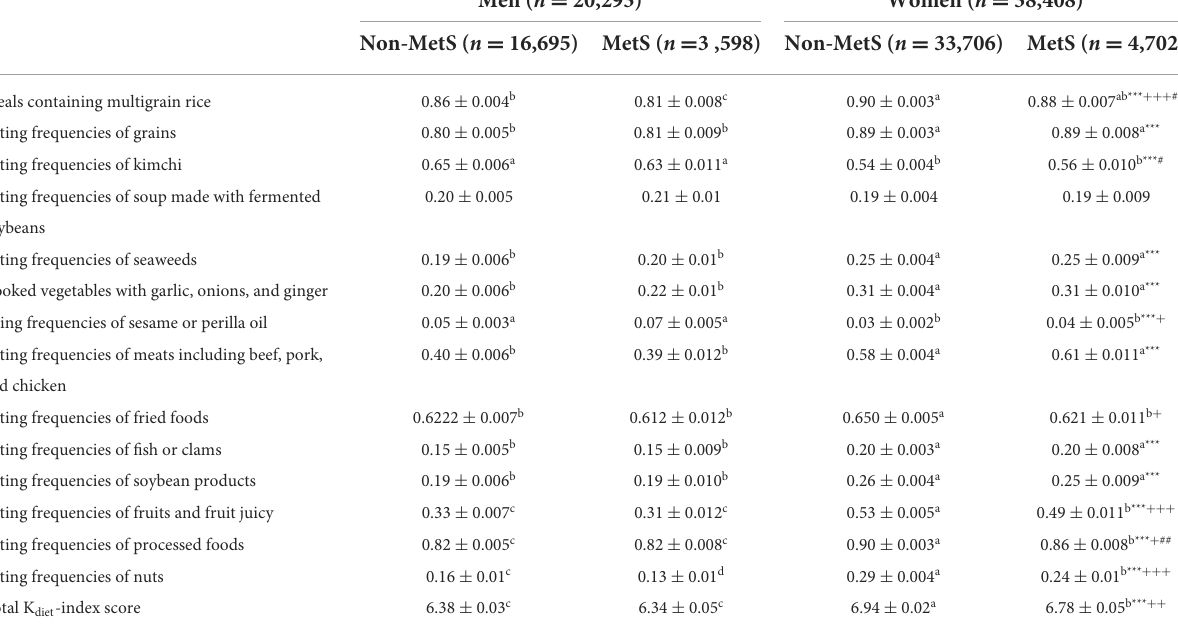
TABLE 5 The K diet -index score of each component for hansik definition according to gender and metabolic syndrome (MetS). Men ( n = 20,293)